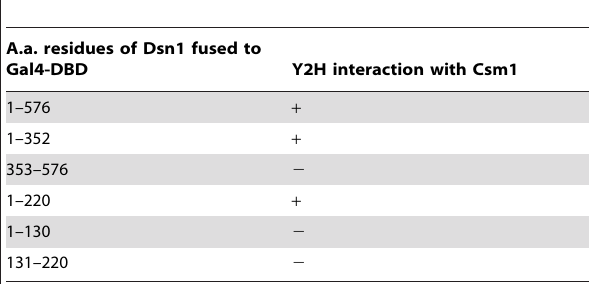
Table 2. Mapping the Dsn1 domain that interacts with Csm1 by 2-hybrid